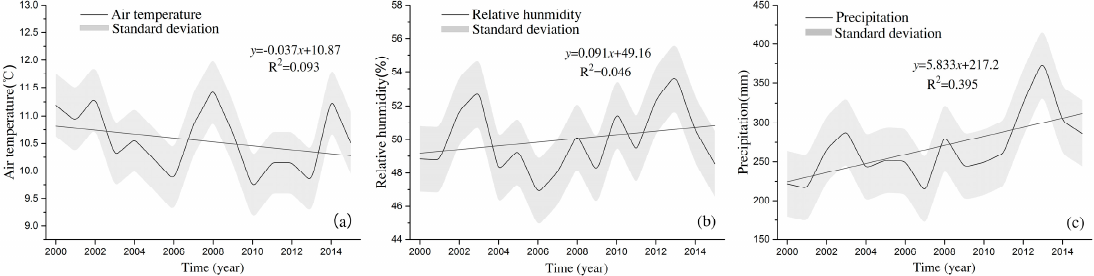
Figure 7. Inter-annual change of air temperature ( a ); relative humidity ( b ); and precipitation ( c ) in IMAR from 2000 to 2015.